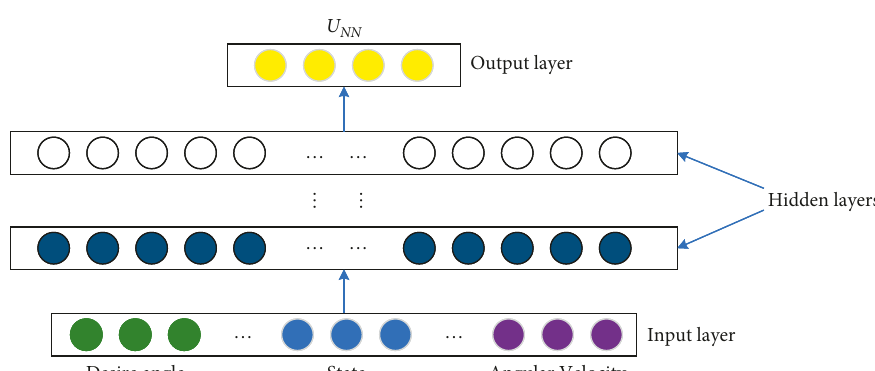
Figure 5: Attitude control structure.